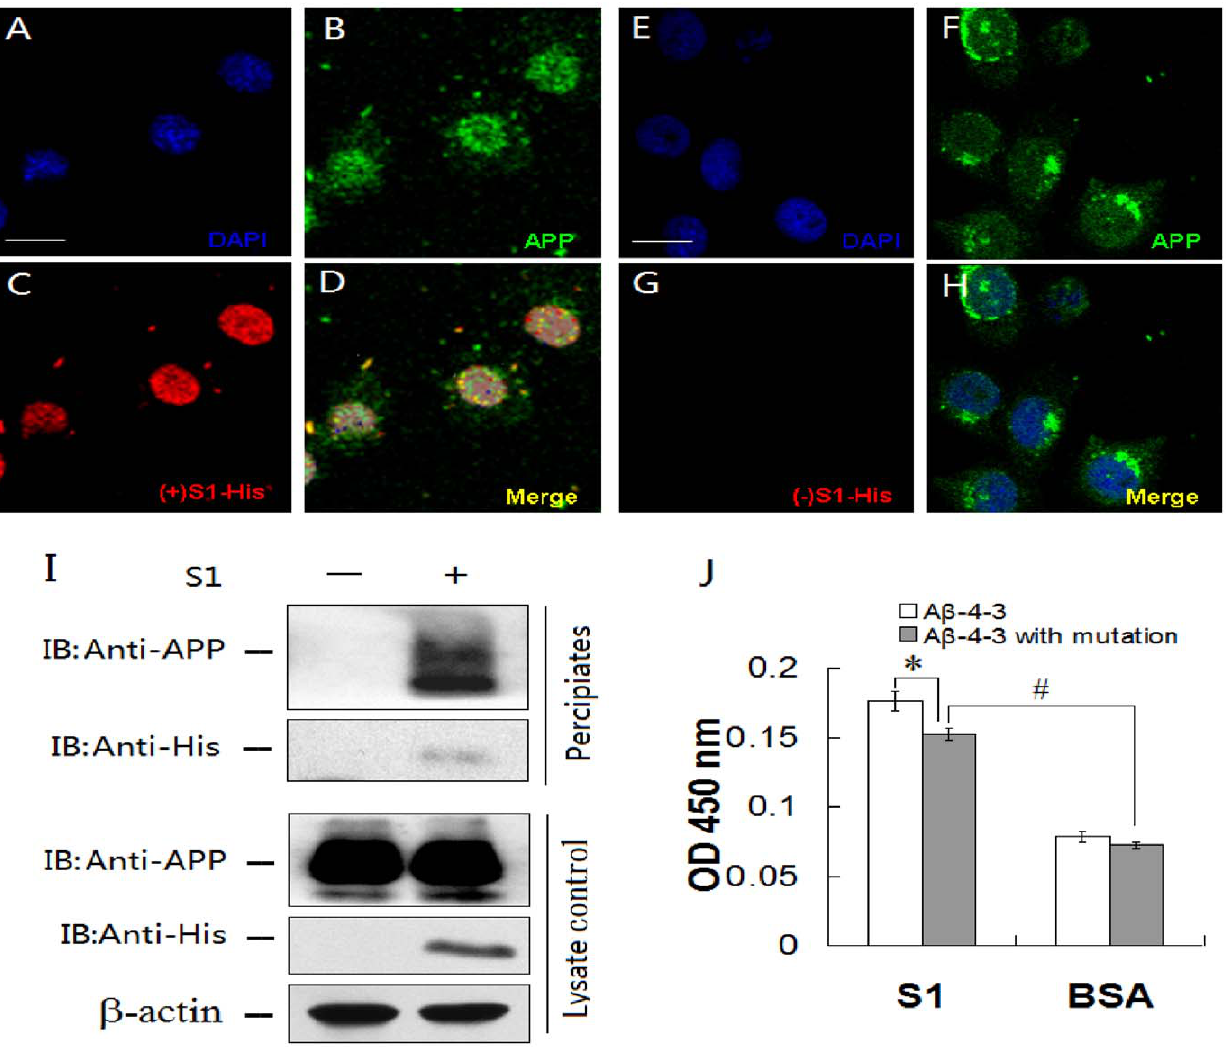
Figure 4. Binding of S1 to cellular APP and mutated b -proteolytic site. 7PA2 cells were incubated with (A–D) or without (E–H) S1-His tag and then stained with DAPI (A, E), anti-APP antibody (B, F) and anti-His tag antibody (C, G), and merged (D, H). The immunostained cells were visualized with a confocal laser scanning microscope (the scale bars=20 m m). (I) 7PA2 cell lysates were incubated with S1-His tag, anti-His tag antibody and then protein G agarose beads. The precipitated complexes were separated by SDS-PAGE and then detected by Western-blot. Lysates without immunoprecipitation were detected as a control. (J) Binding of S1 to mutated b -proteolytic site was detected by ELISA. S1 was coated to the plate and the muted A b -4-3 (M-1A/D-1A) with His tag was added for ELISA assay (*, P , 0.05; # , P ,